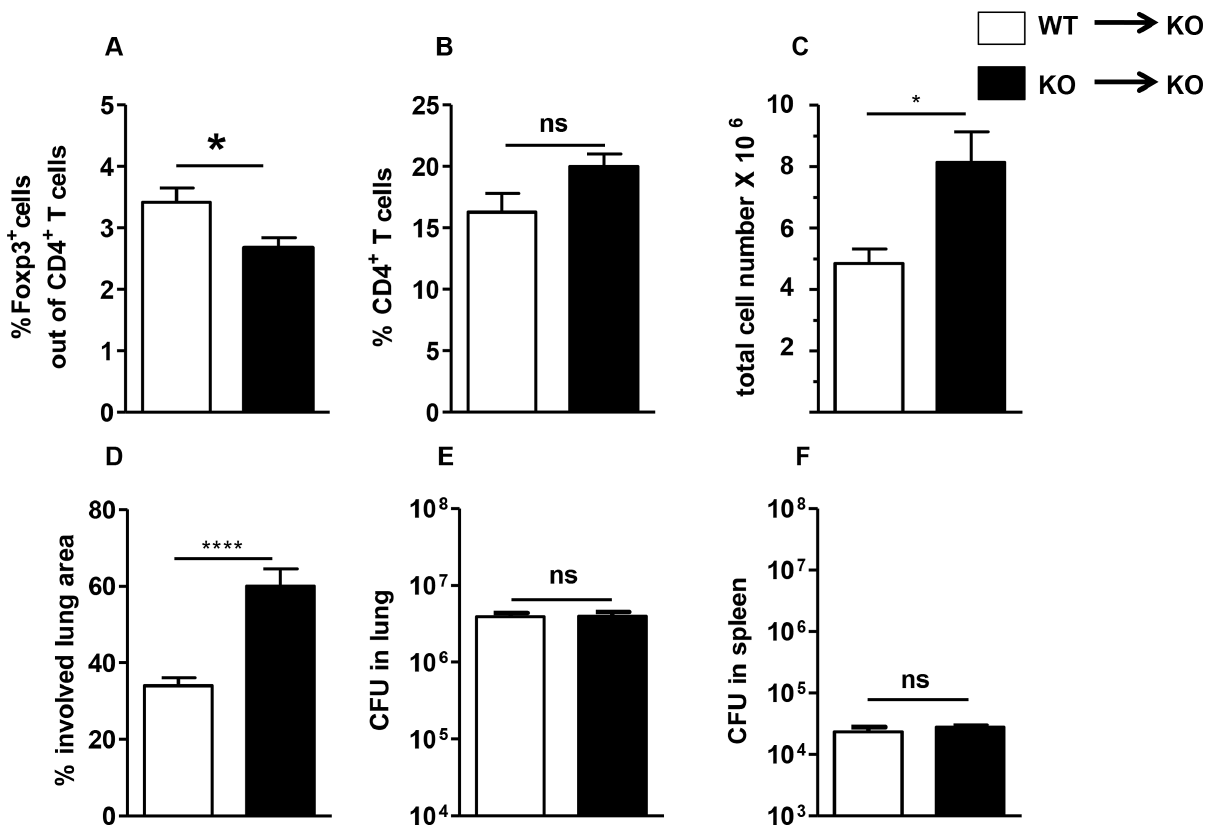
Figure 6. Rescue of WT phenotype in TLR2KO mice following intra-tracheal instillation of WT macrophages. TLR2KO mice were intra- tracheally instilled with 2.5 6 10 6 WT peritoneal macrophages (WT R KO) or TLR2KO peritoneal macrophages (KO R KO) one day prior to infection with a low-dose of Mtb. Single cell suspensions were prepared at week 7 post-Mtb infection. Lung cells were stained with antibodies against CD4 and Foxp3, followed by flow cytometric analysis. Expression of Foxp3 is presented as a percentage of the gated CD4 + cell population (A). Percentage of CD4 + cells was determined by gating on CD4 + cells from total lymphocytes gated (B). Total number of viable cells in the lungs was determined by trypan blue exclusion method (C). Percentage of involved lung area was quantitated by superimposing a grid overlay onto photomicrographs of H&E stained lung sections taken with a 5 6 objective lens. One representative section per mouse was used for quantitation (D). Bacterial burden in the lungs (E) and spleen (F) was determined by plating serial dilutions of tissue homogenates onto 7H11 agar plates. Data include 5–6 mice per group and are presented as mean 6 SEM. *, p , 0.05; **** , p , 0.0001.